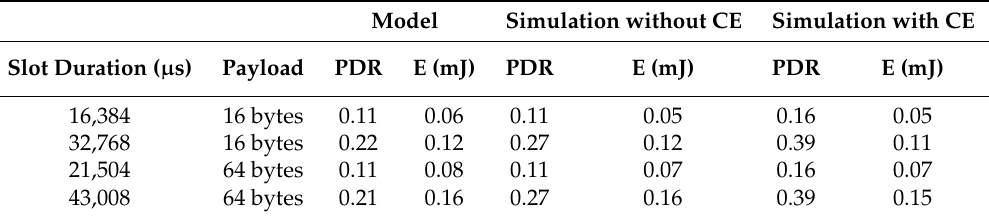
Table 5. Overview of the comparison between analytical model, simulation and simulation with capture effect (CE) for 300 kbps, 16 stations (STAs) per slot.